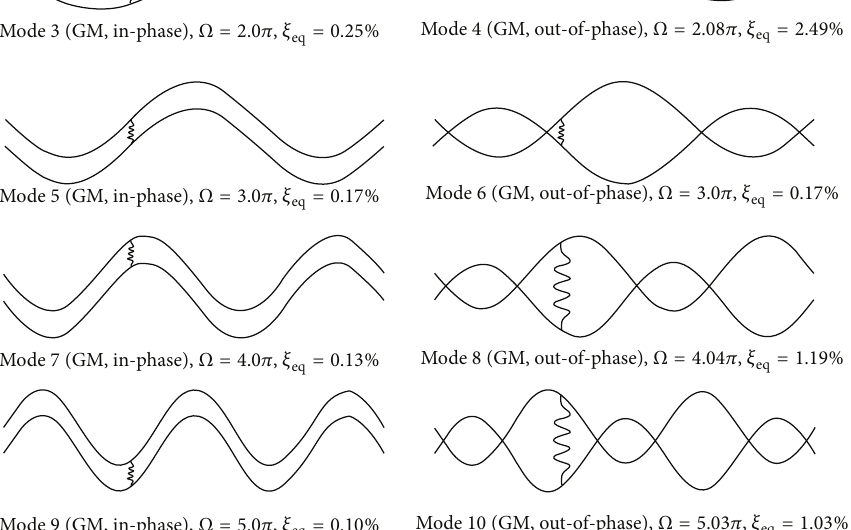
Figure 2: First ten modes of a twin-cable network with a damped flexible cross-tie ( 𝐾 𝑐 = 30.54 kN/m, 𝐶 𝑐 = 1.0 kN ⋅ s/m) at 𝜀 = 1/3 .